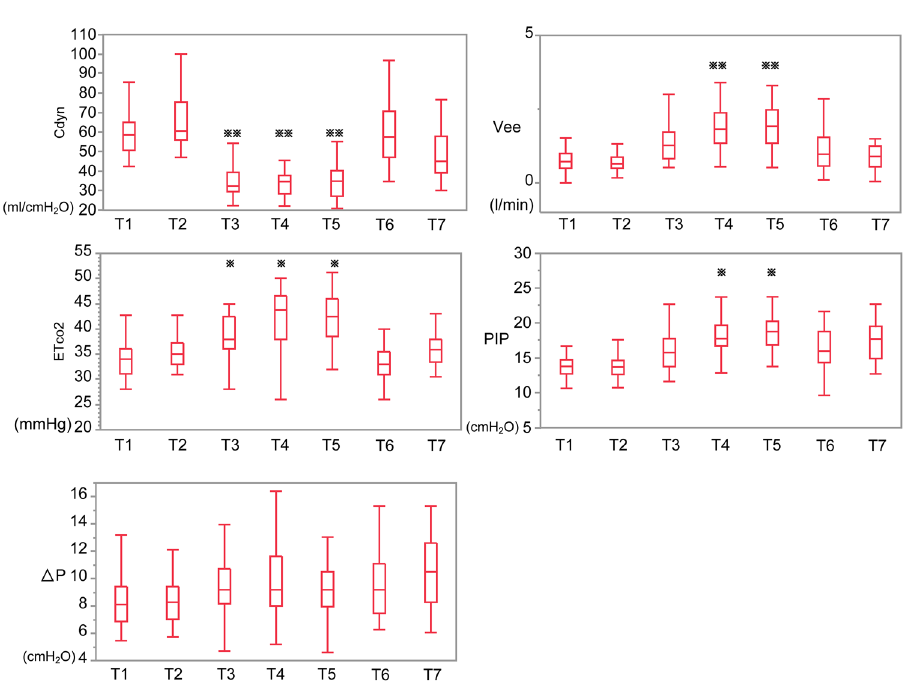
Figure 2. Intraoperative changes in respiratory parameters under two-lung ventilation. The horizontal bars indicate the median values. The vertical bars indicate the range, and the horizontal boundaries of the boxes represent the first and third quartiles. *p < 0.05, **p < 0.01 significantly different from T1. T1: supine position, T2: prone position, T3: 10 min, T4: 1 h, and T5: 2 h after the start of artificial pneumothorax, T6: supine position after the end of artificial pneumothorax, T7: 10 min after the start of laparoscopic surgery. Cdyn: dynamic compliance, Vee: Velocity of end-expiratory flow, ETco2: end-tidal carbon dioxide concentration, ΔP: driving